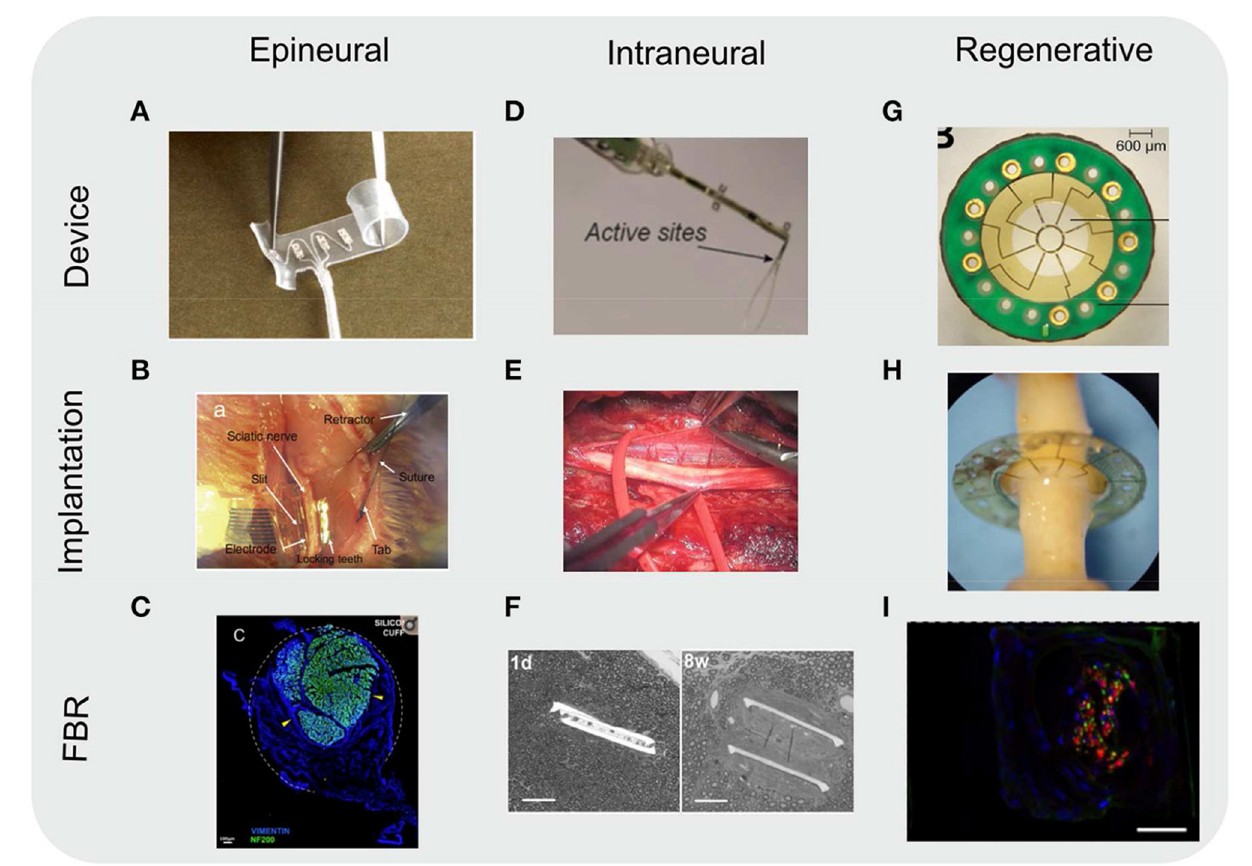
FIGURE 5 | Images of various types of nerve neuroprosthetics. Images included of devices as fabricated (device), implanted into rodent sciatic nerves (implantation), and of the resulting FBR in tissue (FBR). (A-C) Epineurial cuff electrodes. (C) Cross-section of a rat sciatic nerve implanted with a silicone cuff 30 days post-implantation. Nerve (represented by immunoflurescently labeled axon marker NF200, green) take up a small portion of the cuff, with the rest filled with fibroblasts (vimentin, blue) due to FBR to the cuff. Dotted white line indicates approximate position of the cuff. Yellow arrowheads indicate compression of the nerve due to growing fibrotic tissue. Scale bar: 100 µ m. (D–F) Intraneural electrodes, either transverse intrafascicular multichannel electrodes (TIME) (D,E) or longitudinally implanted intrafascicular electrodes (LIFE) (F) . (F) Toluidine blue-stained images of nerve cross-sections. The two branches of the LIFE parylene C implant (slits in tissue) are found in close proximity to the axons (small circular structures) 1 day (1 d) post-implantation. By 8 weeks post-implantation (8w) a fibrotic capsule (seen as a smooth ring around the implant slits) develops, displacing the axons. Scale bar: 50 µ m. (G–I) Regenerative sieve (G,H) and microchannel (I) electrodes. (I) Cross-section of a rat sciatic nerve regenerated through a PDMS microchannel implant (image of a single microchannel) 12 weeks post-implantation. Nerve tissue (represented by immunoflurescently labeled axon marker NF, green; and Schwann cell S100, red) take up a small portion of the microchannel cross-section. The remainder of the microchannel is filled with other cell types (nuclear stain DAPI, blue), likely macrophages and fibroblasts as a result of FBR to the microchannel walls. The outline of the image represents the approximate position of the microchannel walls. Scale bar: 20 µ m. All images reproduced under the terms of the